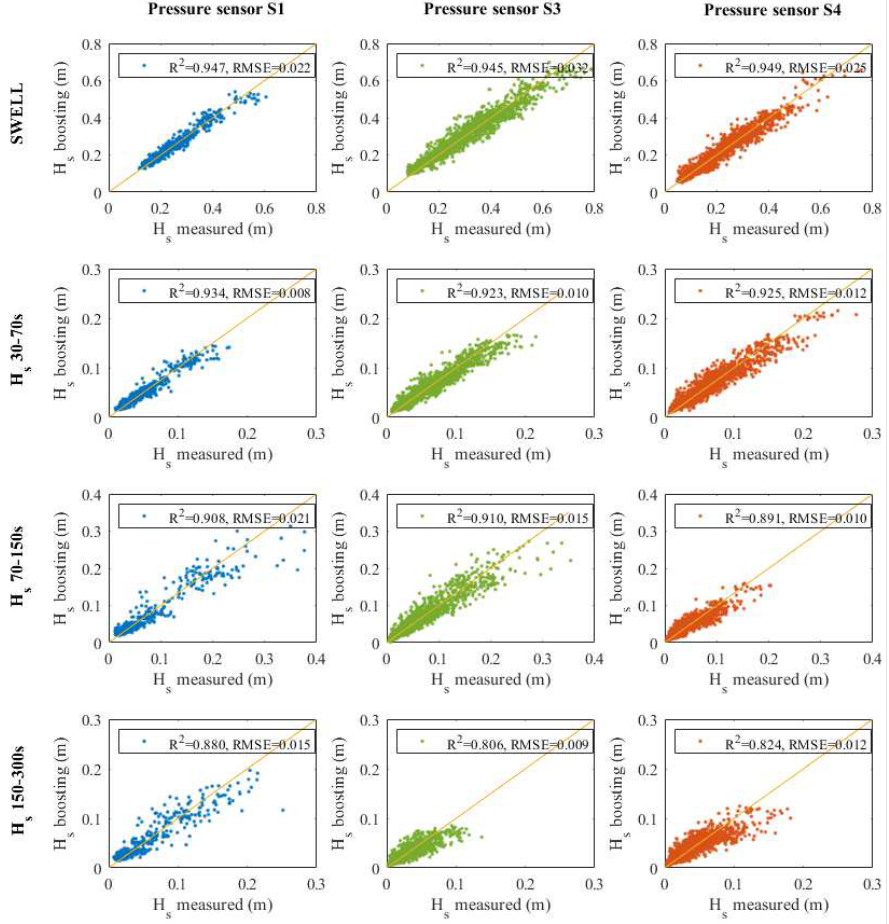
Figure 5. Scatterplots of the data measured by sensors S1 (blue), S3 (green) and S4 (orange) and their prediction with the model in the different frequency bands.